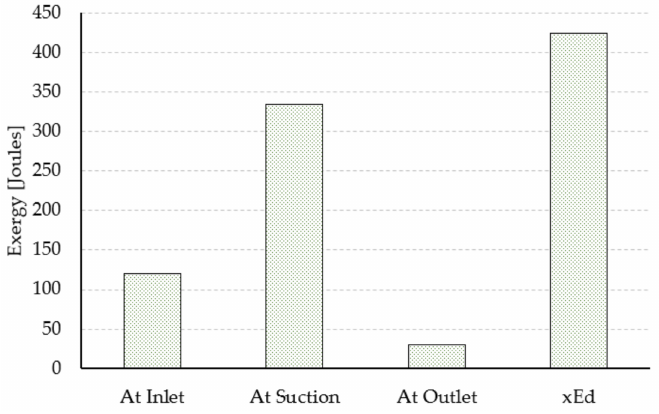
Figure 10. Exergy at different boundary locations in